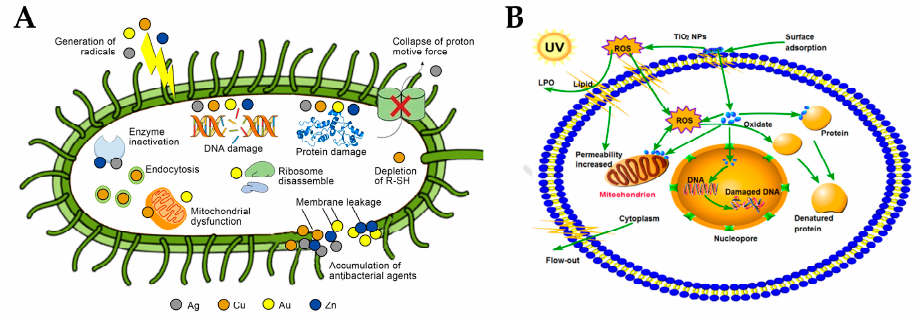
Figure 12. Schematic diagrams of the effect of metal ions ( A [121]) and TiO 2 ( B [123]) particles on on cells.